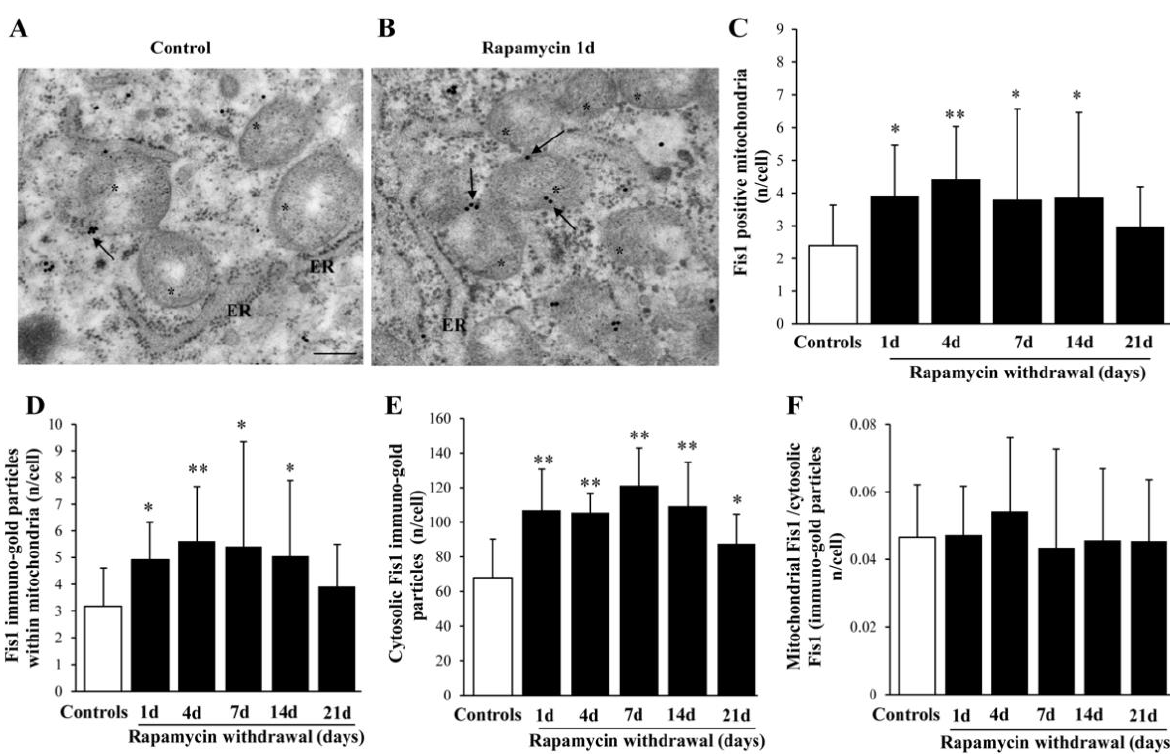
Figure 11. Representative immuno-gold and polarization graphs for the mitochondrial fission marker FIS1. Representative TEM micrograph showing FIS1-positive mitochondria from control ( A ) and following 1 d rapamycin withdrawal ( B ). Arrows point to FIS1 immuno-gold particles within mitochondria. Graphs report the FIS1-positive mitochondria ( C ), FIS1 immuno-gold particles within mitochondria ( D ), the cytosolic amount of FIS1 ( E ), and the ratio of mitochondrial to cytosolic FIS1 particles ( F ). Values reported in the graph correspond to the mean ± SD. Mitochondria were counted in 50 cells per group. * p ≤ 0.05 compared with controls. ** p ≤ 0.05 compared with controls and 21 d. Scale Bar = 0.5 µ m, Asterisk (*) = mitochondria, ER = endoplasmic reticulum.